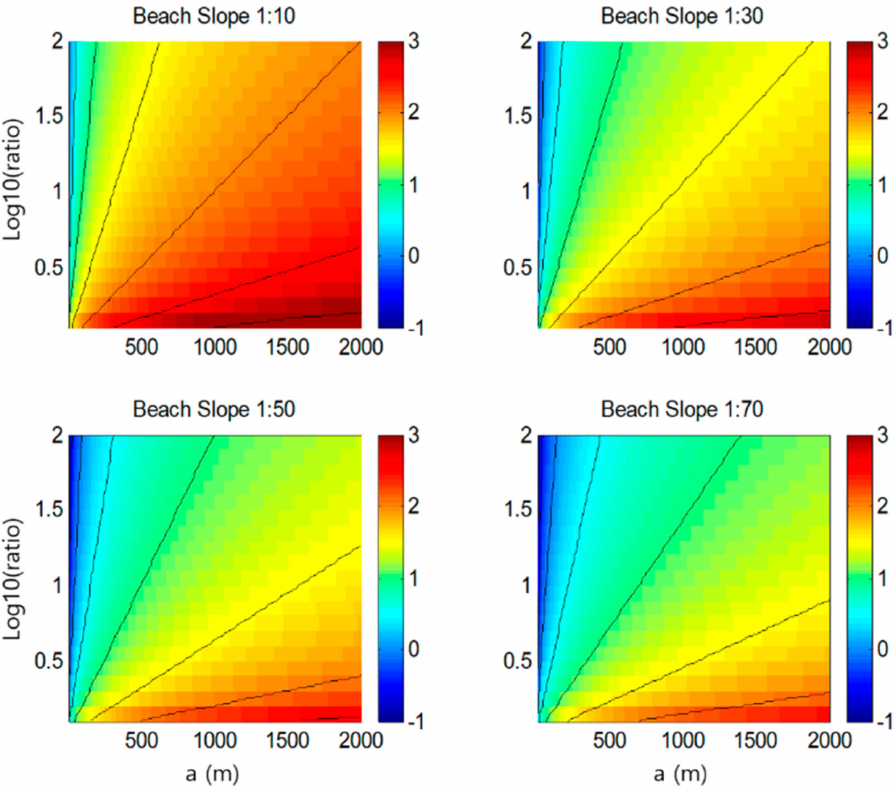
Figure 8. Correction factor against offshore distance and incident wave height (w.r.t 1:10, 1:30, 1:50, and 1:70)